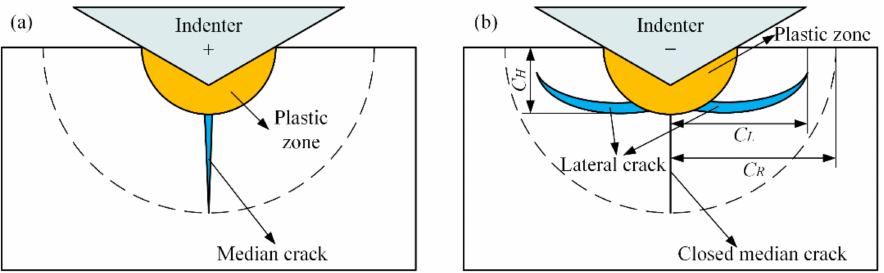
Figure 1. Microfracture model for brittle materials: ( a ) loading and ( b ) unloading.